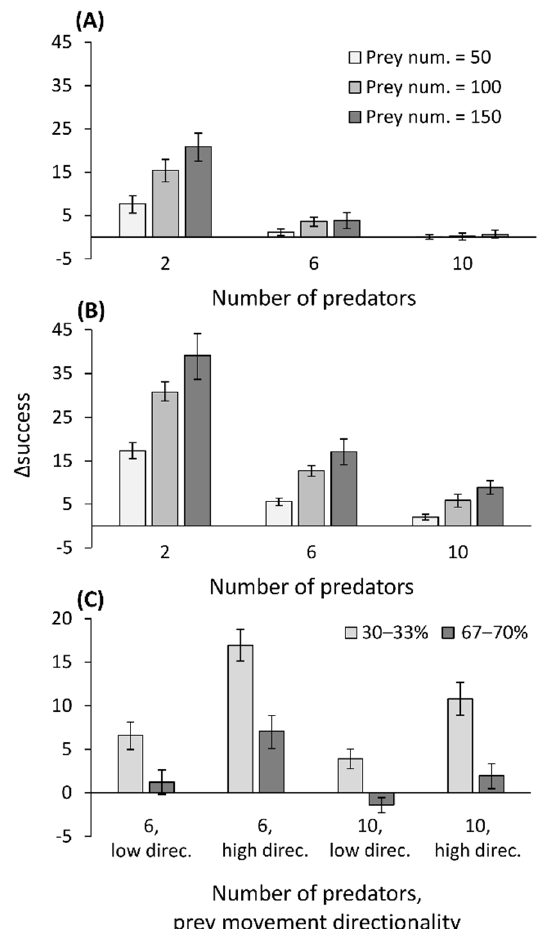
Figure 5. The simulation results. The Δ success (the number of prey caught by predators next to the wall minus those caught by predators at random positions) simulating three prey densities (50, 100, and 150 prey), and predator densities (2, 6 and 10), when: ( A ) prey move less directionally (a prob- ability of 0.6 to keep moving in the initial direction), or ( B ) more directionally (a probability of 0.9 to keep moving in the initial direction). ( C ) A change of the ratio of predators next to the wall vs. predators in random positions (ca. one-third vs. ca. two-thirds), using two predator densities (6 and 10) and low and high directionality of prey movement (low direc. and high direc. stand for low and high movement directionality of the prey). Means and 95% confidence intervals are presented.